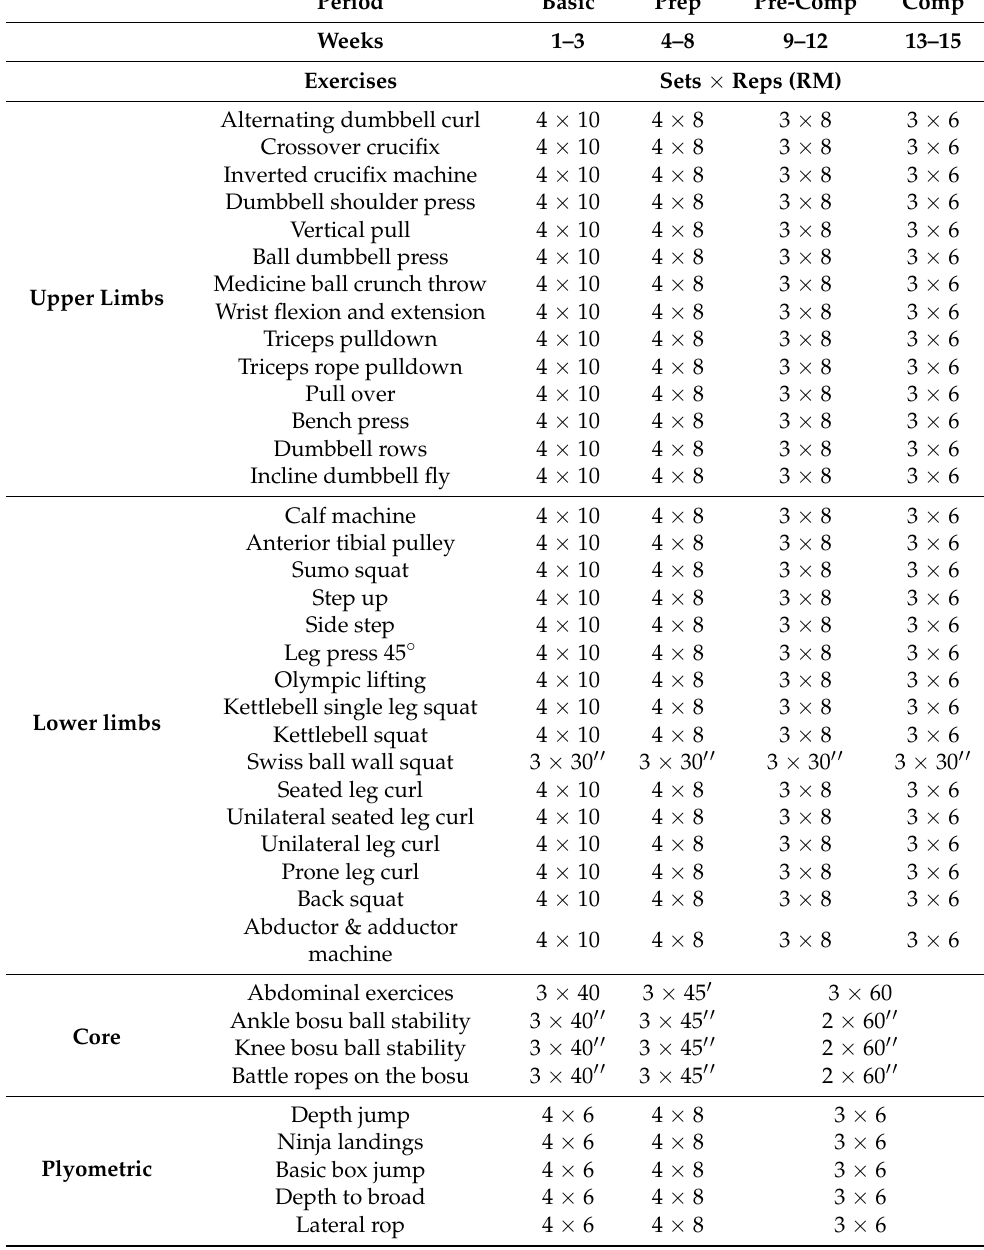
Table 2. The training program performed during 15 weeks of the